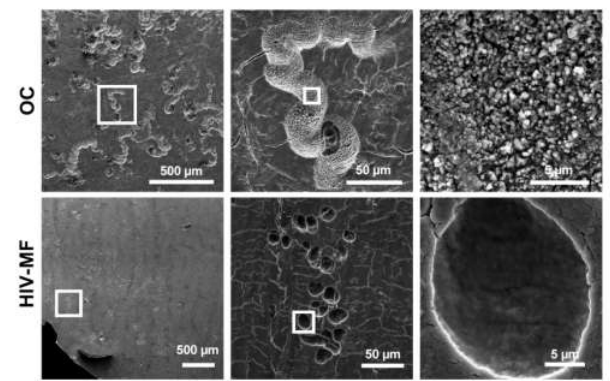
Figure 3. Superficial bone resorption by HIV-1-infected MF compared to OC. Monocytes were seeded on bone slices and di ff erentiated into MF or OC. At day 7, MF were infected with HIV-1. At day 14, cells were removed and bone slices were stained with toluidine blue. Representative scanning electron microscopy images showing bone resorption pits formed by OC or infected MF (HIV-MF, NLAD8 strain). Scale bars